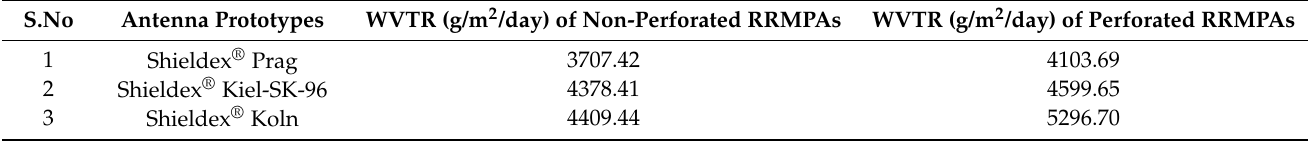
Table 7. Water Vapor Transmission Rate of all non-perforated and perforated antennas.